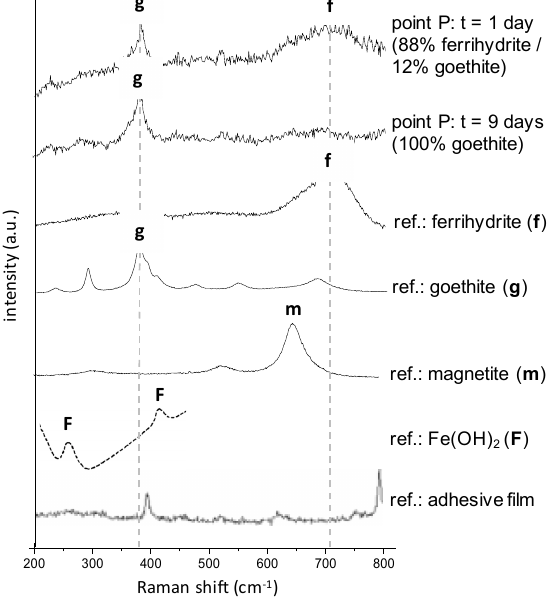
Figure 8. Raman spectra at point P identified on Figure 7, after one and nine days of exposure to deaerated water. The ‘reference’ spectra of the pure phases are also presented (ferrihydrite, goethite, and magnetite from [9]; Fe(OH) 2 from [35]; adhesive film). The contribution of the adhesive film of the cell was substracted from the experimental spectra.